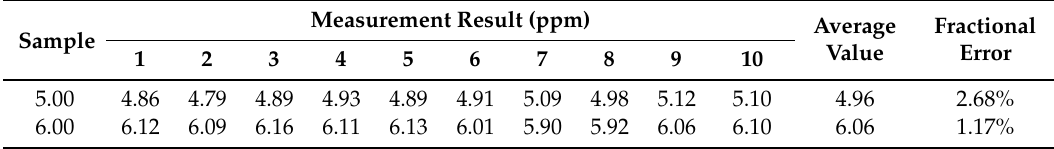
Table 3. Stability of the Measurements.